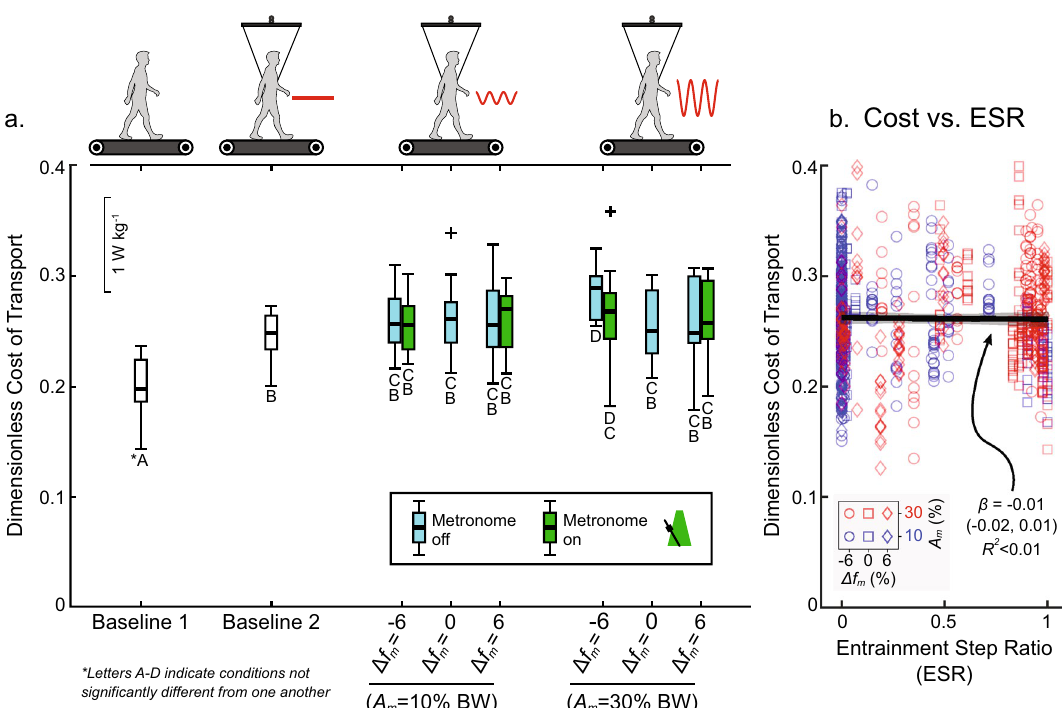
Figure 5. Metabolic power does not depend on entrainment. ( a ) Non-dimensional metabolic power was compared by oscillation parameters and metronome status (on or off) using a mixed linear regression. A post hoc Tukey Honestly Significant Difference test was used to compare estimates of metabolic power in the model. Box plots are labelled with letters (e.g. A–D) indicating conditions where power is not significantly different. Outliers are marked with “+”. See Table S2 in the Supplementary Materials for full results. Baseline 1 and 2 refer to walking on the treadmill without and with the harness, respectively. Box plots are shown for all